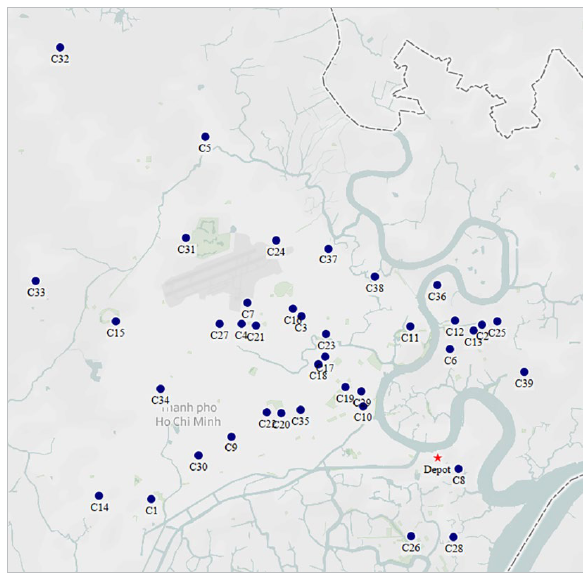
dow 10 operation system. Figure 2. Customer and depot locations (source: current